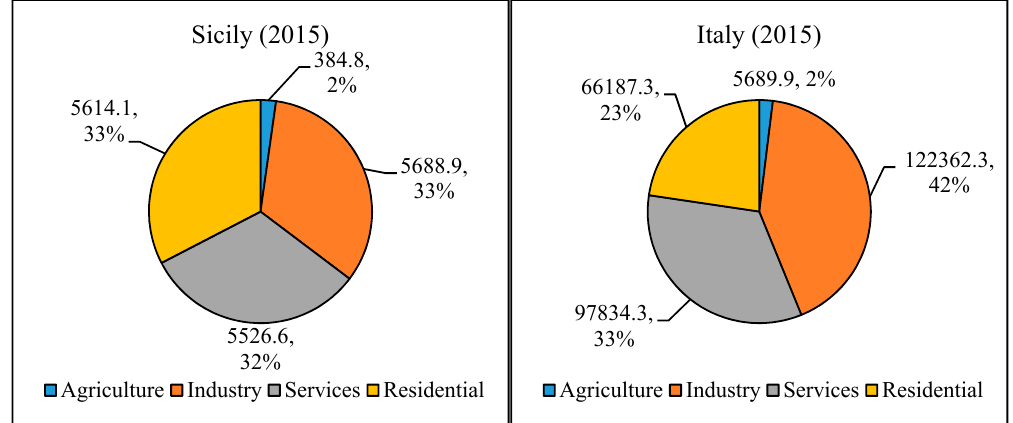
Figure 6. Comparison of electrical energy consumes by sectors in Sicily and Italy, during 2015.